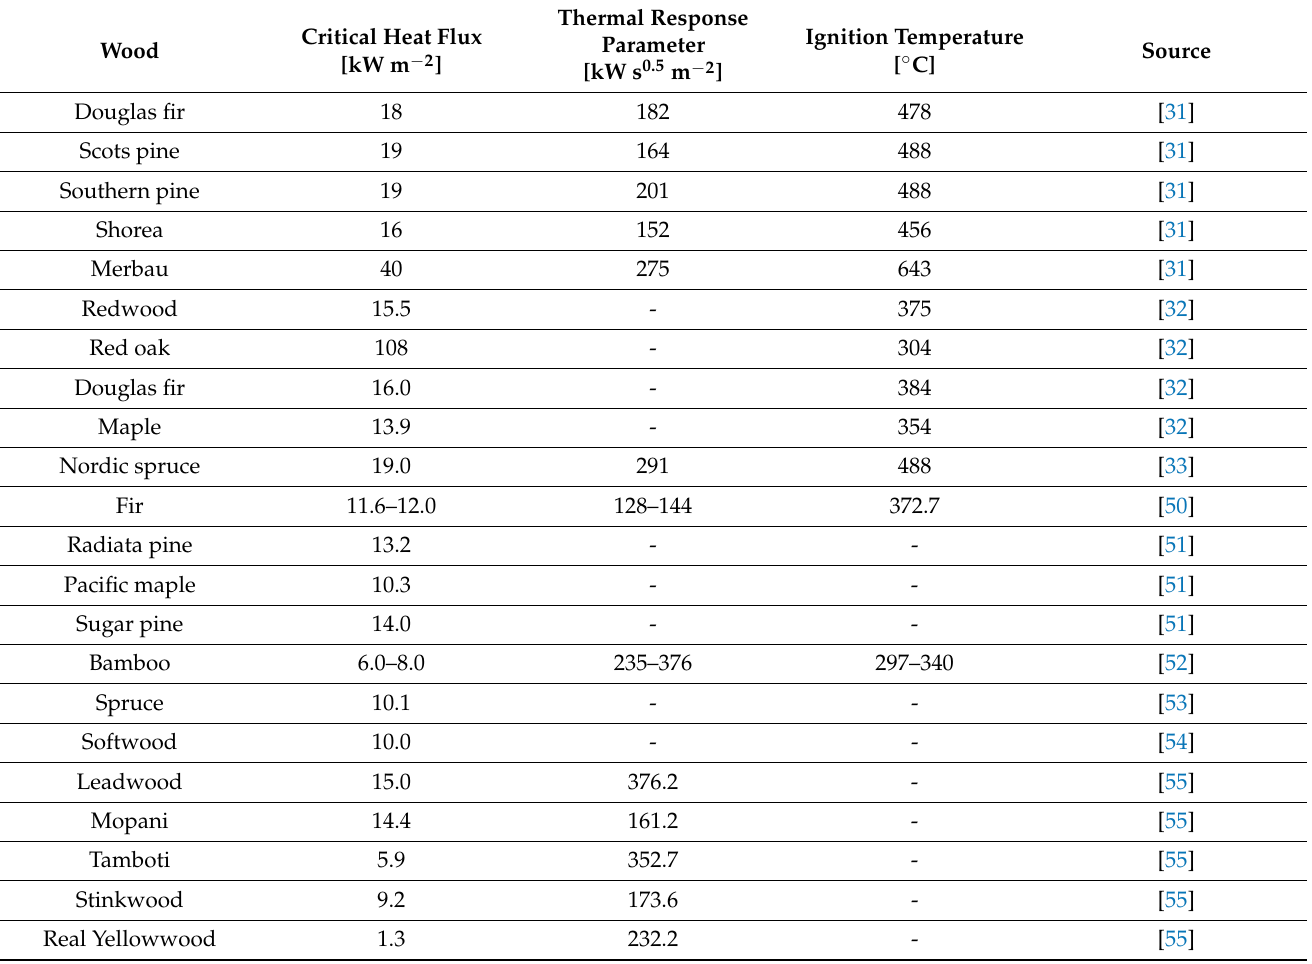
Table 10. Critical heat fluxes and thermal response parameters of selected types of